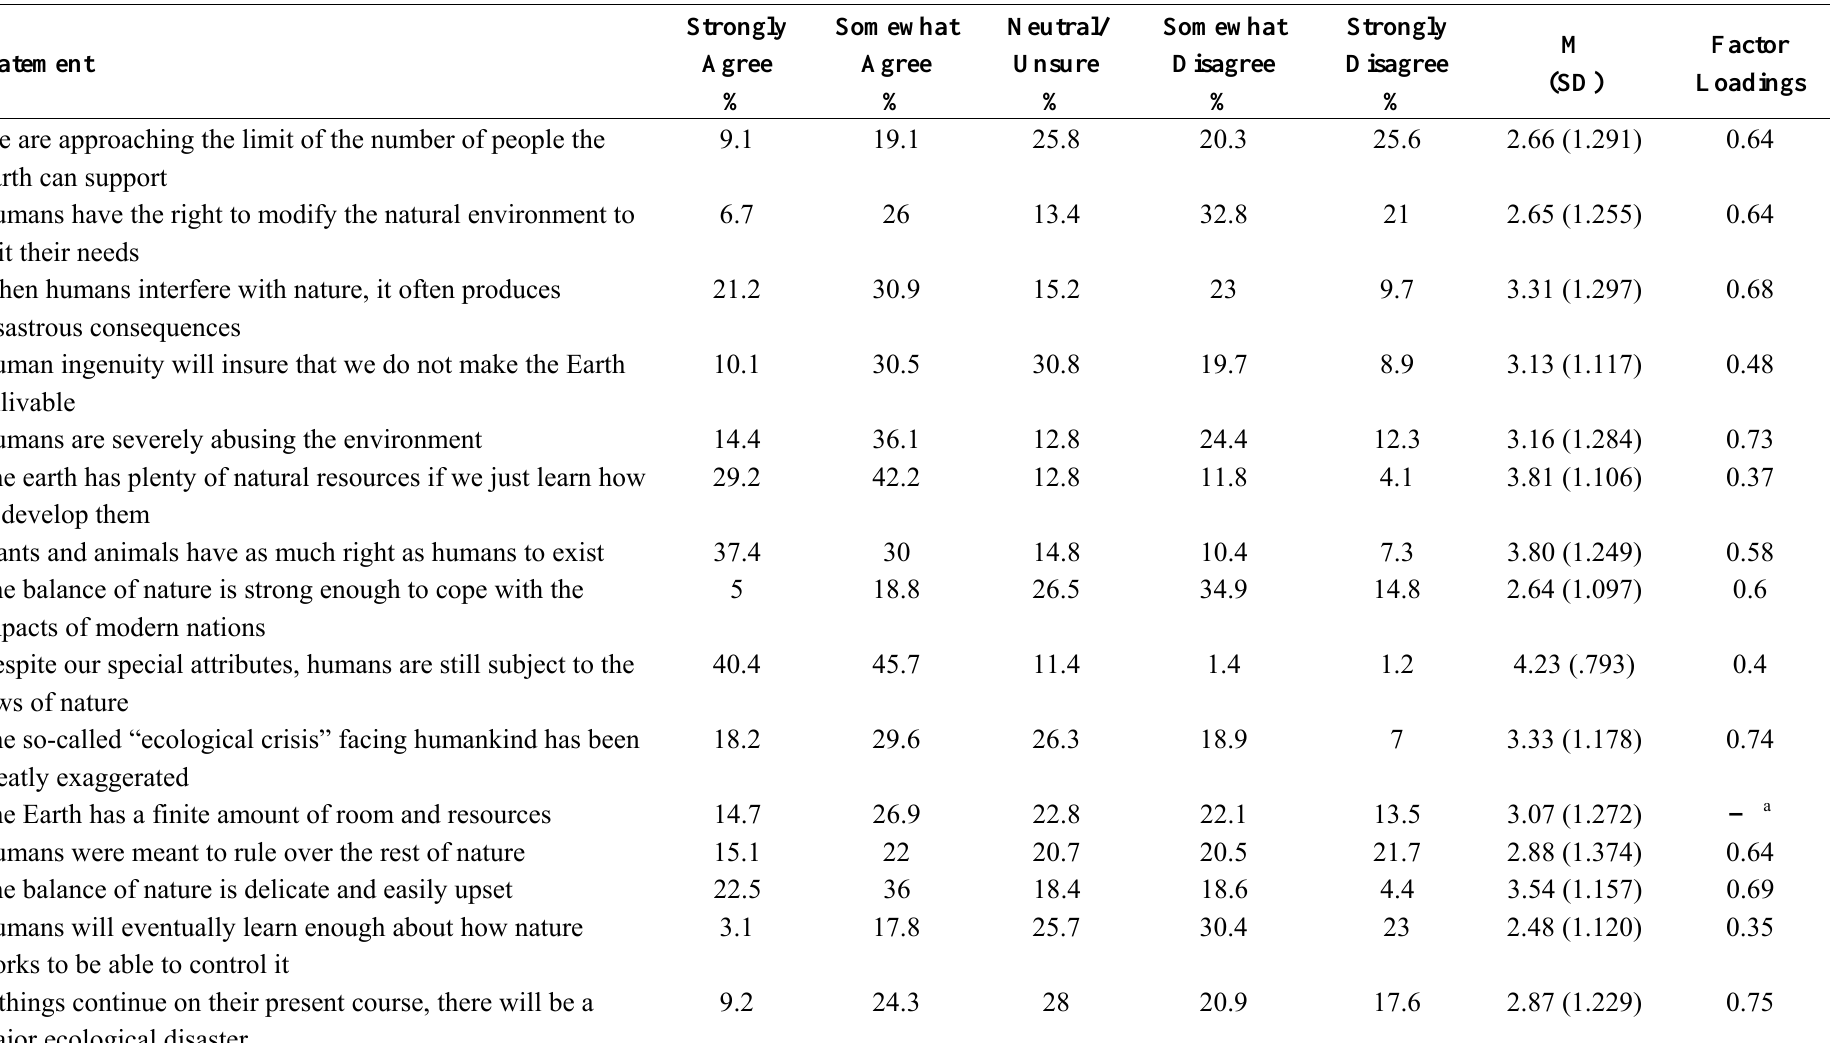
Table 5. Descriptive Statistics and factor loadings of recreation experience